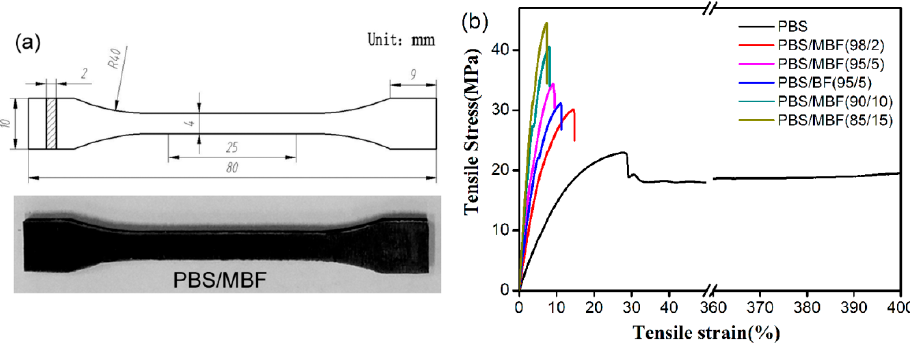
Figure 8. ( a ) Standard tensile samples; ( b ) stress-strain curve of PBS, PBS/BF, and PBS/MBF.